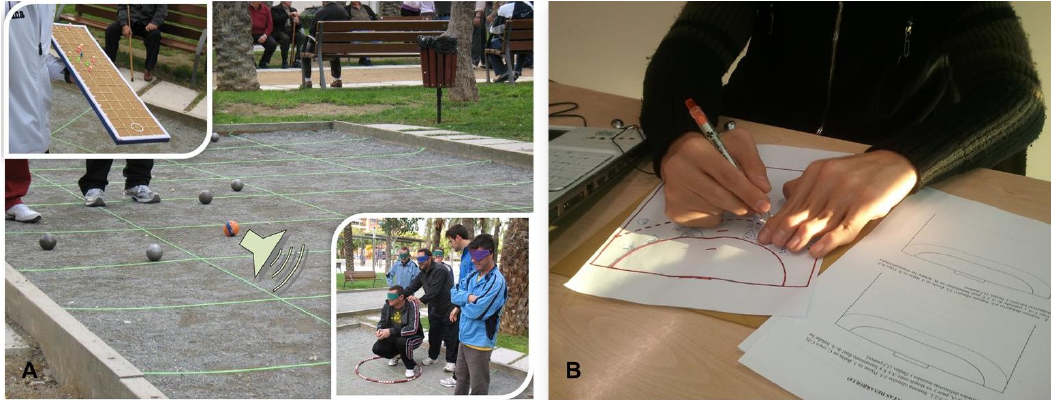
Figure 4. Materials and development of adapted petanque (A); adapted template during team sports evaluation